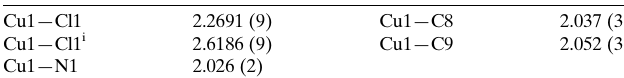
Table 2 Selected bond lengths (A˚ ) for II .